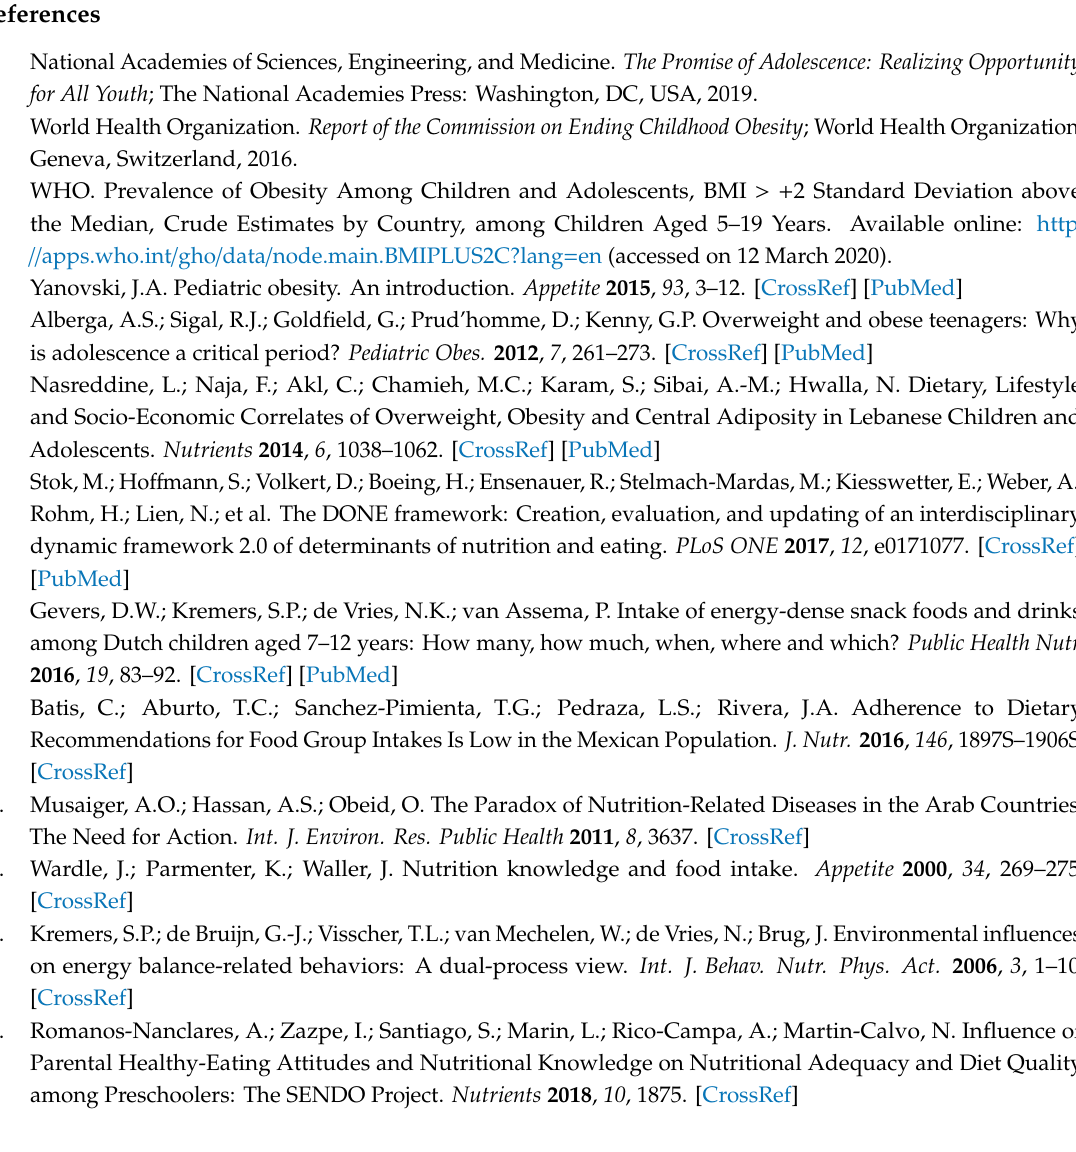
Table S1: Responses to the Dietary Knowledge Questionnaire by the adolescents and their parents. Table S2. Responses to the Dietary Adherence Questionnaire of the adolescents and their parents. Table S3. Between group comparisons of the healthy items and unhealthy items scores of the adolescents and their parents. Table S4. Between group comparison of separate Dietary Adherence Questionnaire (DAQ) items according to demographic characteristics. Table S5: Pearson’s correlations between the DAQ items of adolescents. Table S6: Pearson’s correlations between the DAQ items of adolescents and the DAQ items of the parents, the total knowledge score of adolescents, and the BMI z